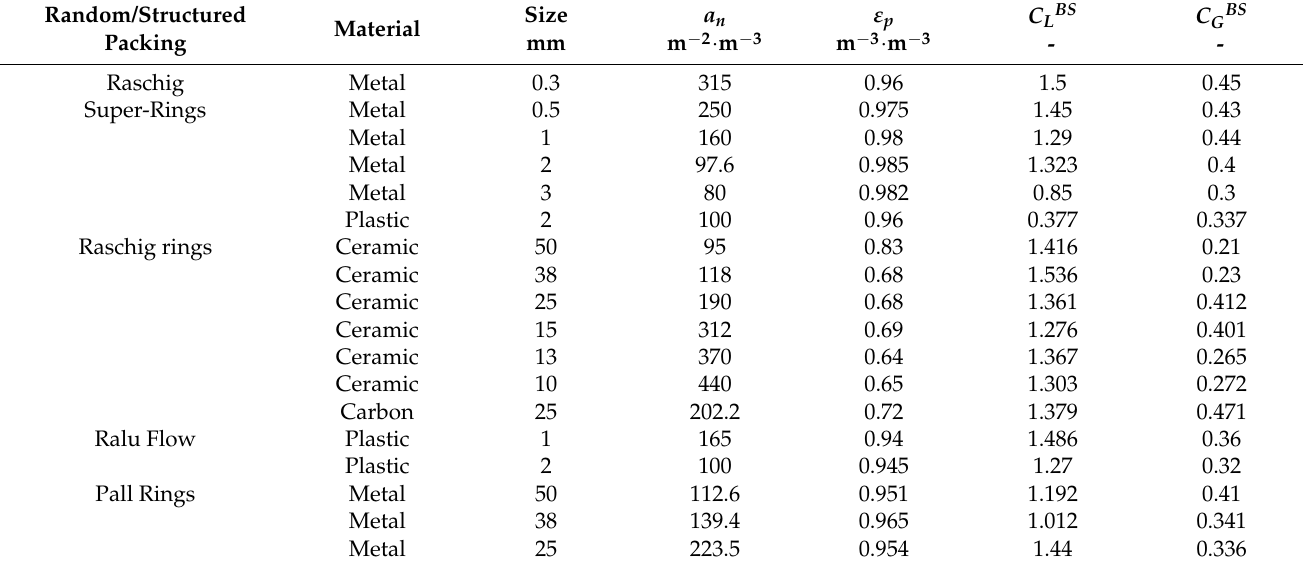
Table 4. Characteristic data of several packings and specific constants C LBS and C GBS [15].